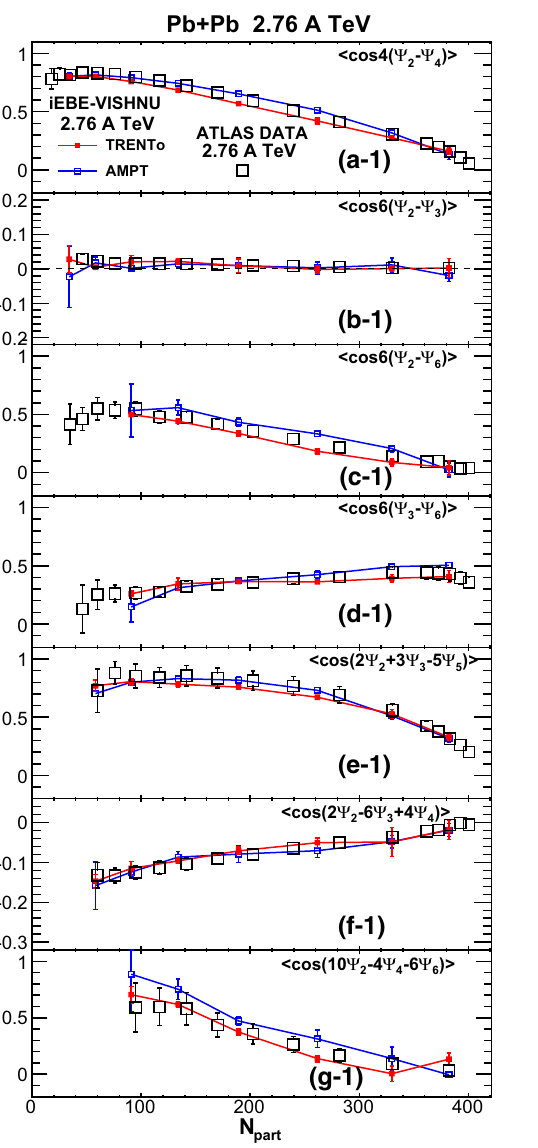
both TRENTo and AMPT initial conditions, iEBE-VISHNU can roughly reproduce the ATLAS data in 2.76 A